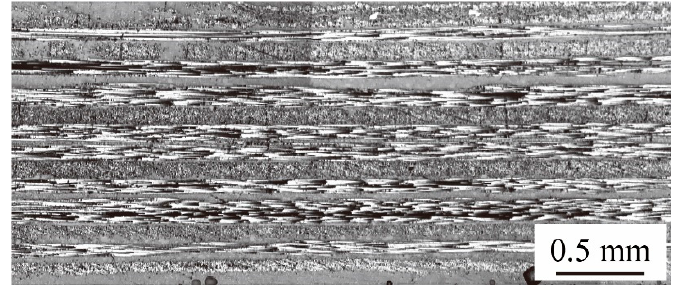
Figure 1. A cross section of a 1.6 mm thick thermoplastic carbon-fiber-reinforced-plastic (TP-CFRP) sheet from TOPKEY Inc. [26].